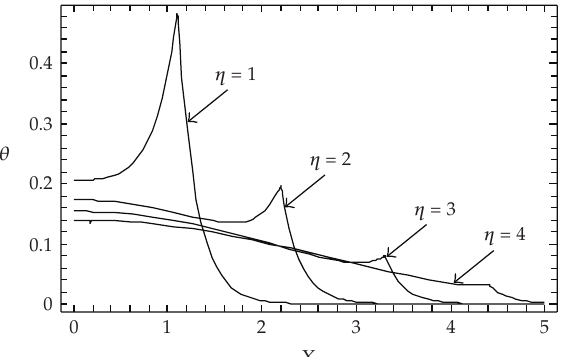
Figure 6: Dimensionless temperature distributions resulting from the hyperbolic model for the (cid:5) 1 , β (cid:5) 5 , and U (cid:5) 0 . 1 instantaneous heat source; φ (cid:3) η (cid:4) (cid:5) δ (cid:3) η (cid:4) , ψ 0